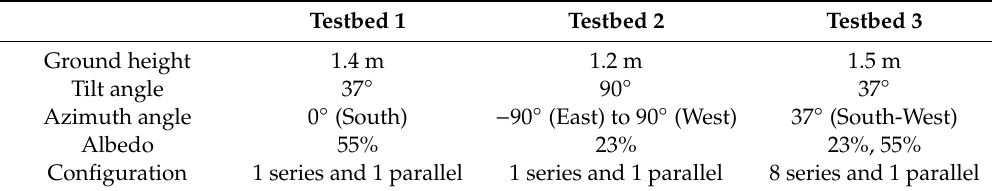
Table 1. Installation conditions of testbeds.